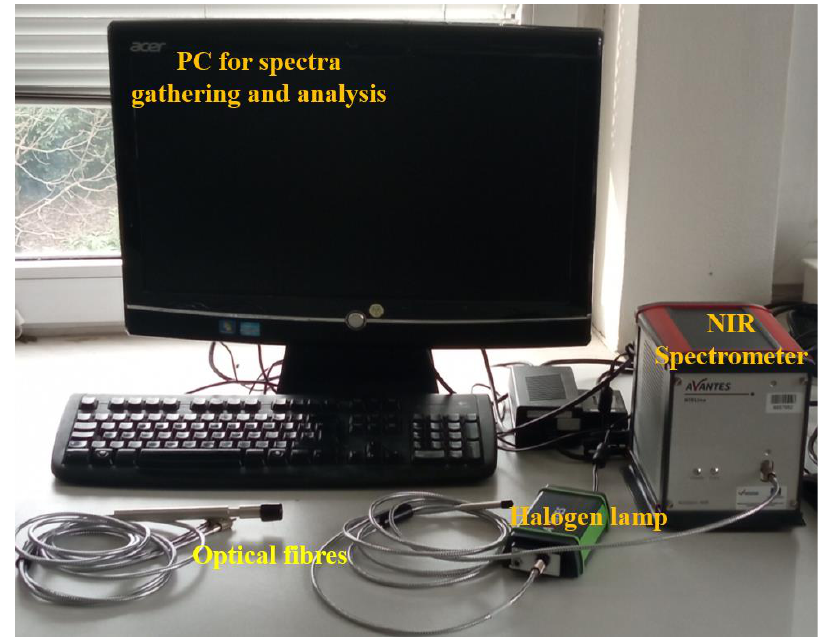
Figure 5. Experimental set up for NIR measurements .